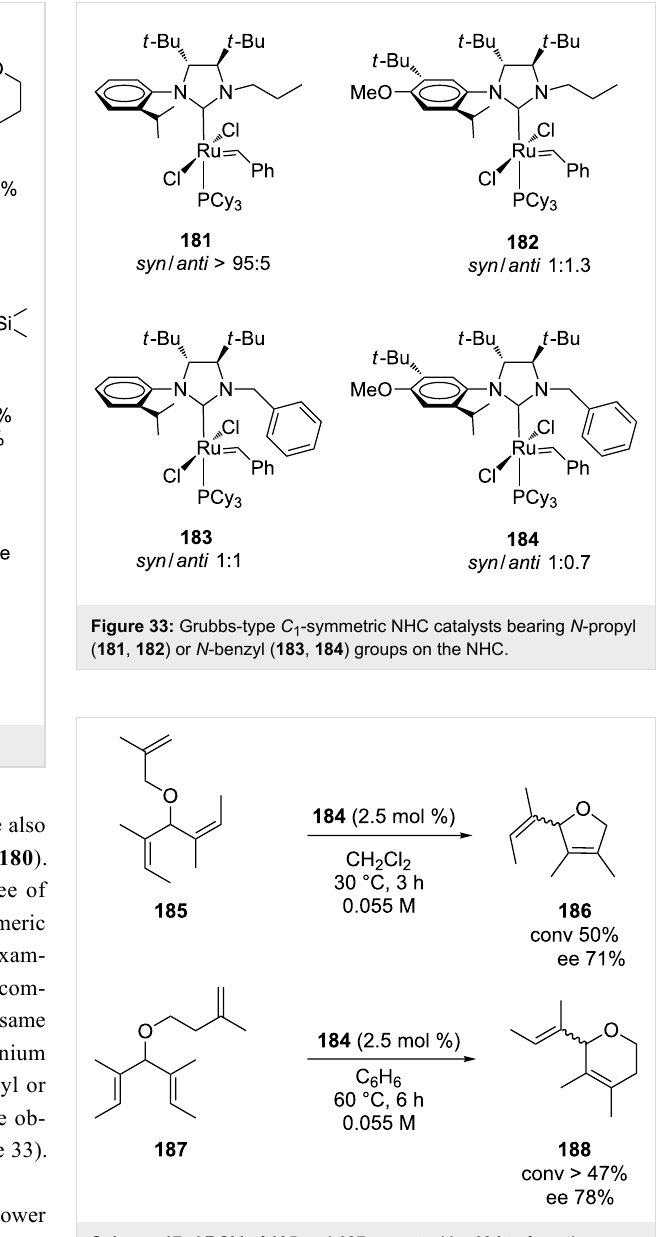
configuration on the backbone positions ( 189 – 192 , Figure